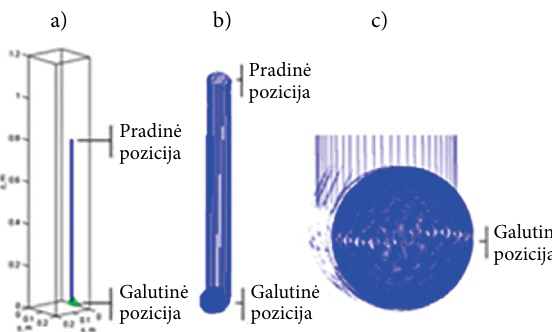
Fig. 1. Orientation of the normal plane of the i th particle’s (here r is the radius vector velocity vector v j i of the i th particle)